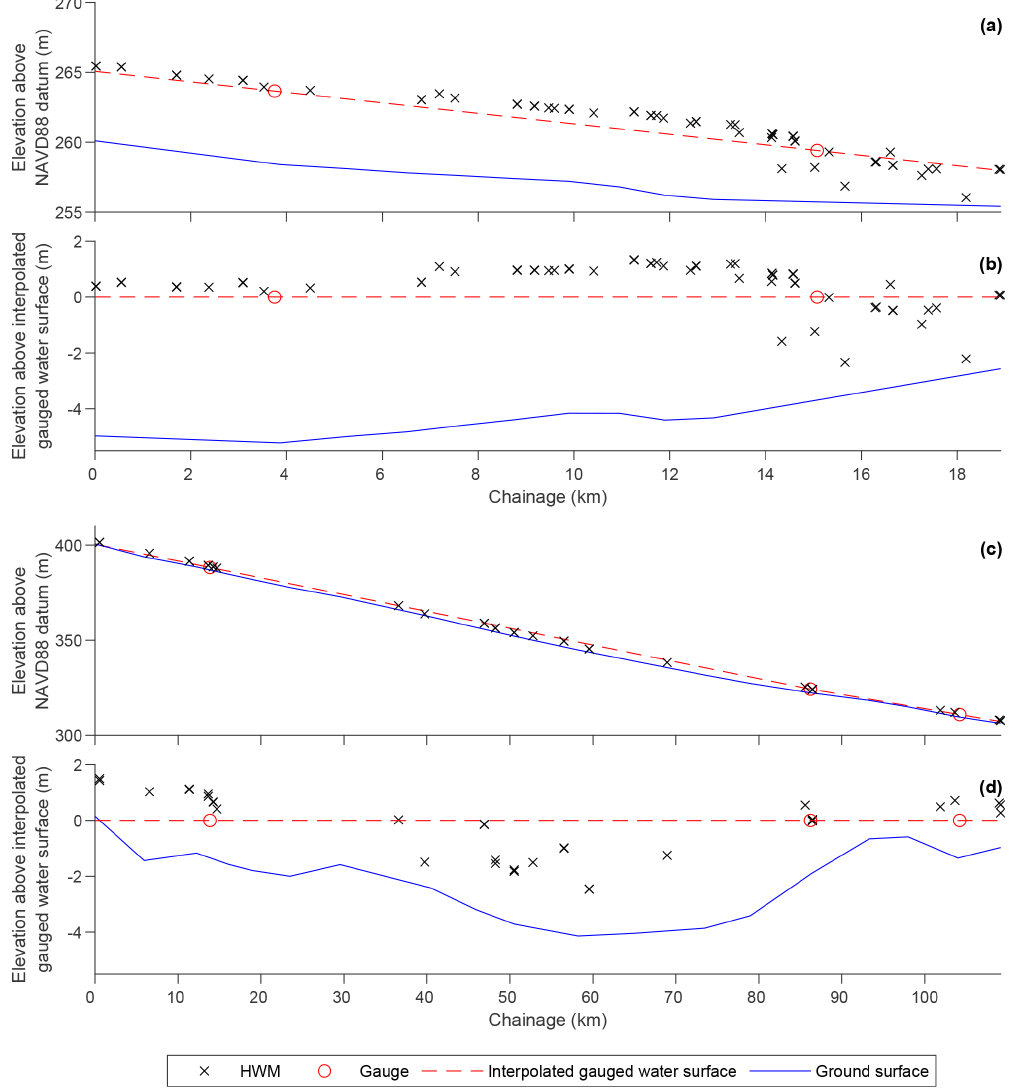
Figure 3. Water surface profiles based on gauge and high water mark data for (a, b) the Cedar River between Cedar Falls and Waterloo, Iowa (event 1), and (c, d) the Platte River near Omaha, Nebraska (event 5). Profiles in (a) and (c) are referenced to mean sea level, while those in (b) and (d) adopt the interpolated gauged water surface as the vertical